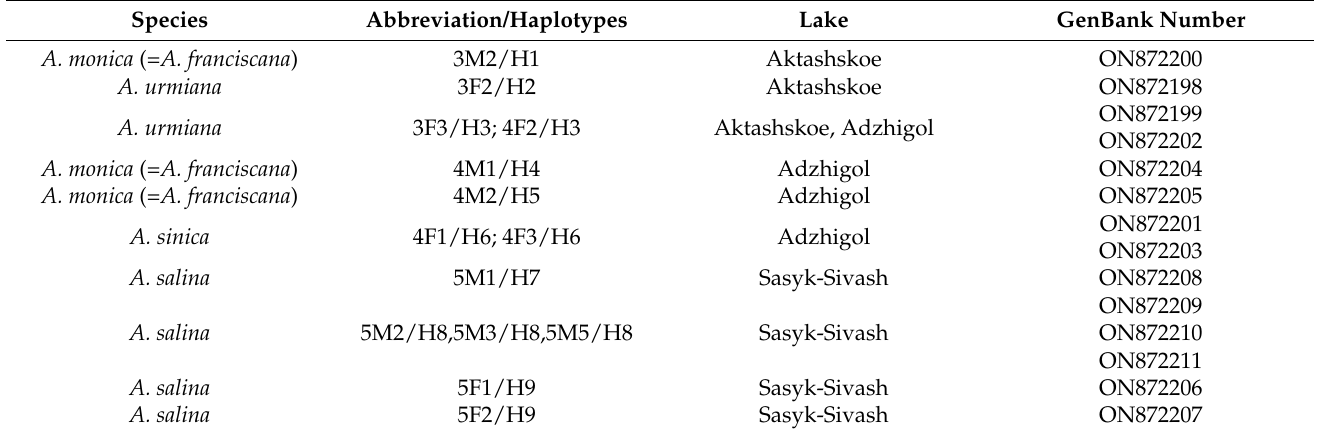
Table 2. Artemia haplotypes found in the Crimean hypersaline